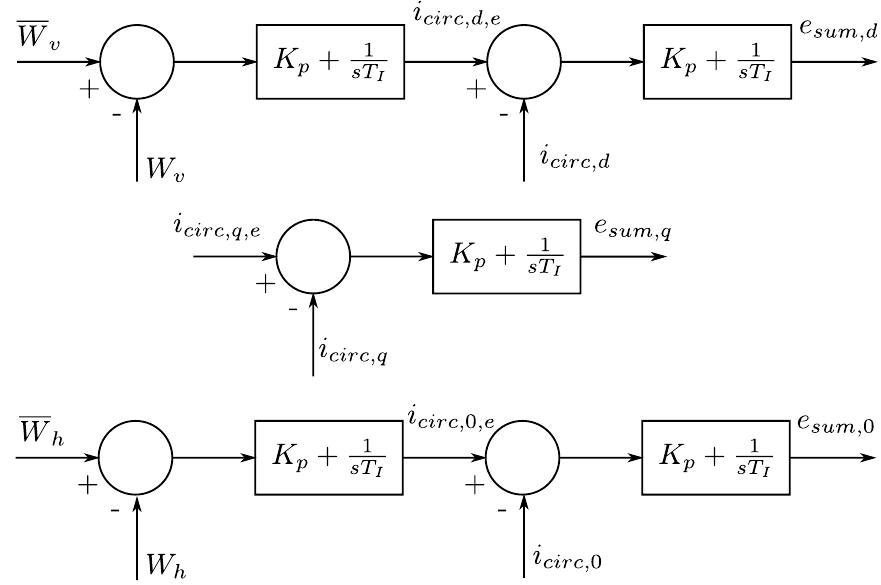
Figure 6. Slave terminal internal dynamics cascaded control structure.